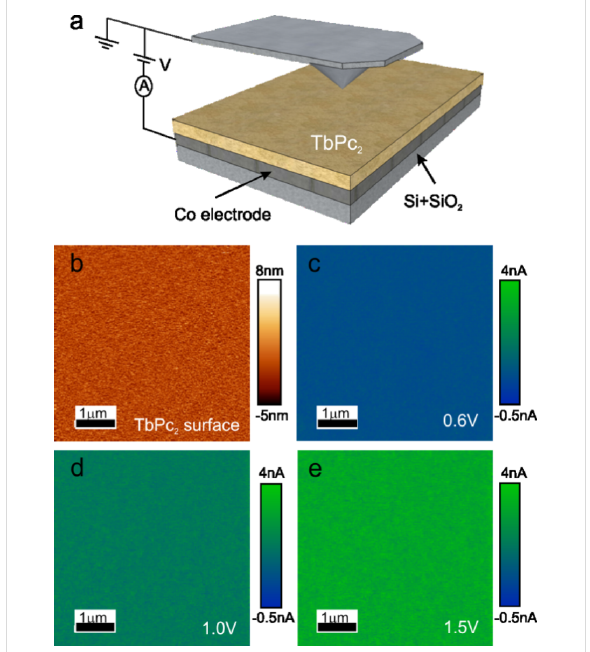
Figure 6: cs-AFM electrical measurements. (a) Electrical setup employed for local electrical measurements via cs-AFM. (b) AFM topography image of an 87 nm thick TbPc 2 film (5 × 5 µm 2 ). Current maps for the same location indicated in (b) for the case of an applied voltage of 0.6 V (c), 1.0 V (d) and 1.5 V (e).